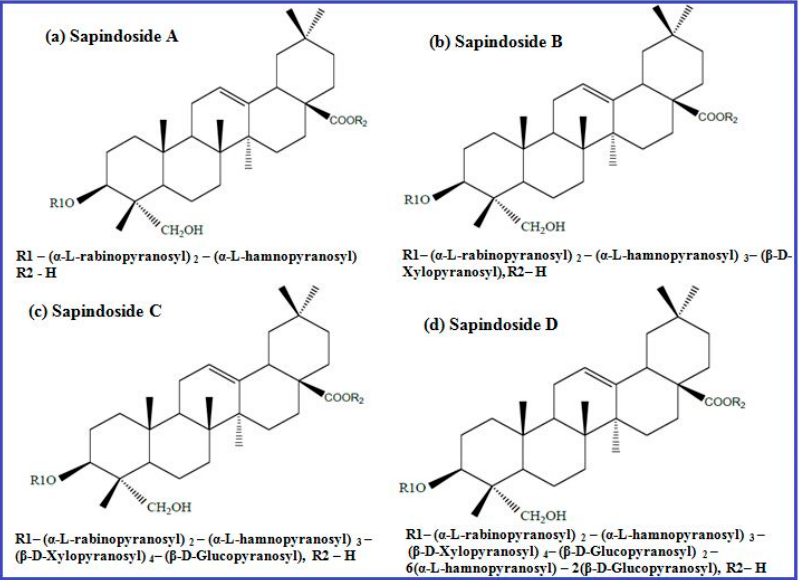
Figure 6. Chemical Structure of different types of saponin present in the SMFE.